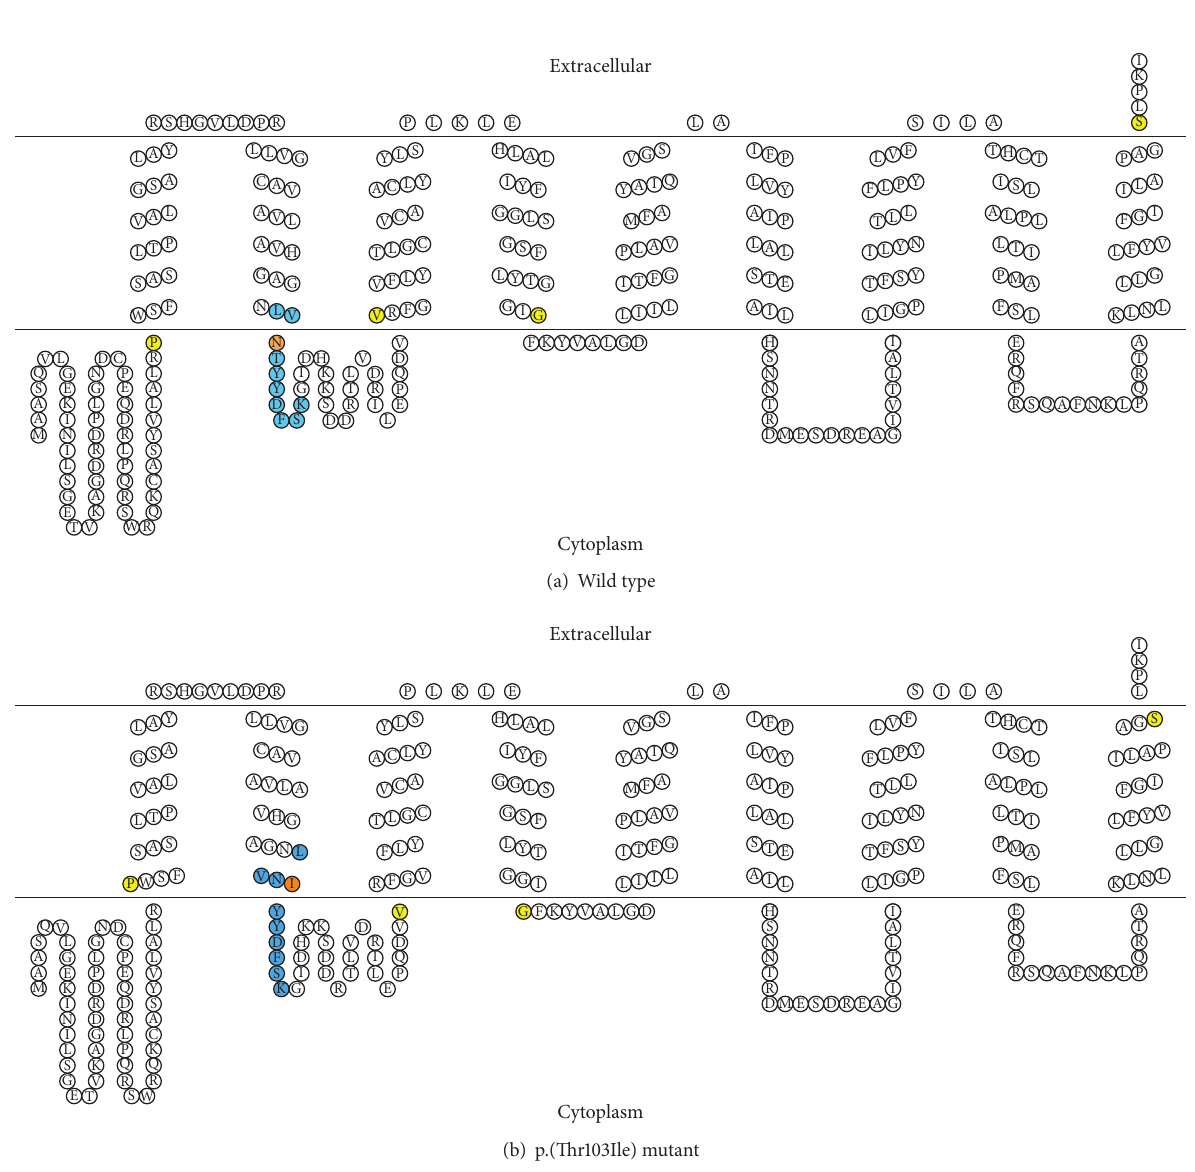
Figure 4: Consensus model of the wild type and mutant UBIAD1 protein. This shows the consensus figure from seven different modeling algorithms. (a) Wild type UBIAD1 protein. (b) UBIAD1 protein with a p.(Thr103Ile) substitution. The CRAC binding domain is shown in blue, and amino acid 103 is shown in orange. All other amino acids affected by structural changes to transmembrane helices caused by the p.(Thr103Ile) substitution are shown in yellow. Note that the folds seen in the diagram do not represent alpha-helices or beta sheets. Rather, they indicate residue location in relation to the cell